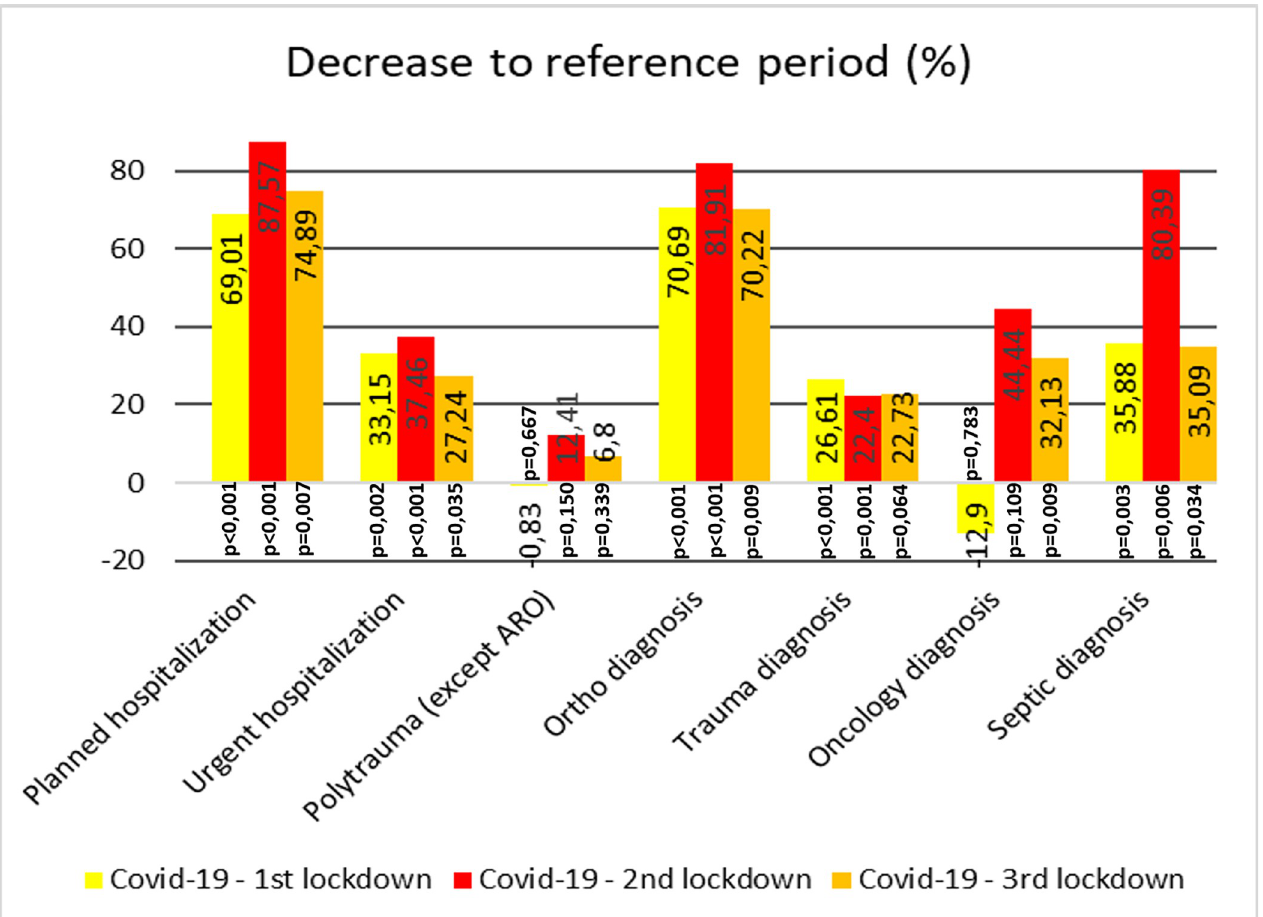
Fig 4. Decrease of admissions and lead diagnoses. Percentage decrease (y-axis) in the number of admissions and lead diagnoses in individual lockdown periods relative to the reference period. Negative values indicate an increase of inpatients. The p value indicates the statistical significance of the decrease.